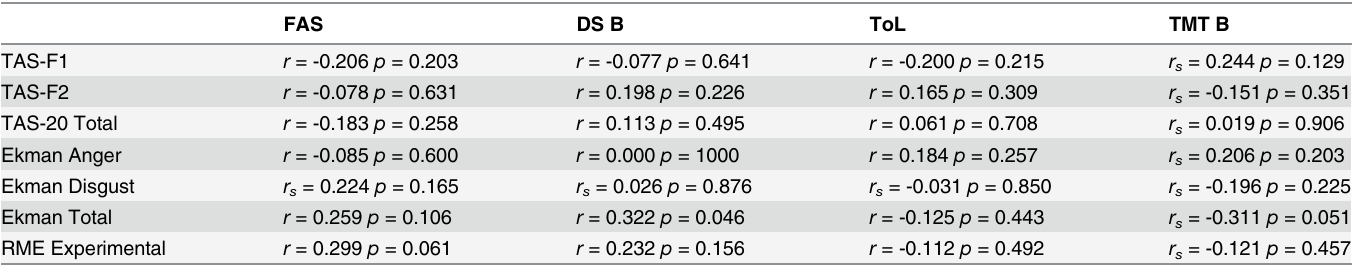
Table 5. Pearson or Spearman correlations in FM group between the four executive function measures and TAS-20, Ekman and